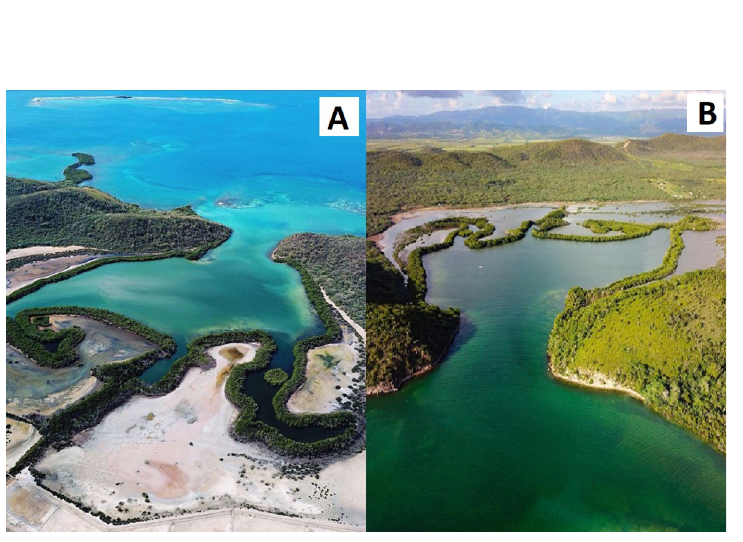
Fig 2. Drone pictures of The Bioluminescent Bay. The picture to the left (A, by Jonathan Vegilla) was shot from the north during the dry season. The picture on the right (B, by Omar Lo´pez) was taken from the south during the wet season. Note the salt flats to the north of the bay, mostly dry in (A) and flooded in (B).